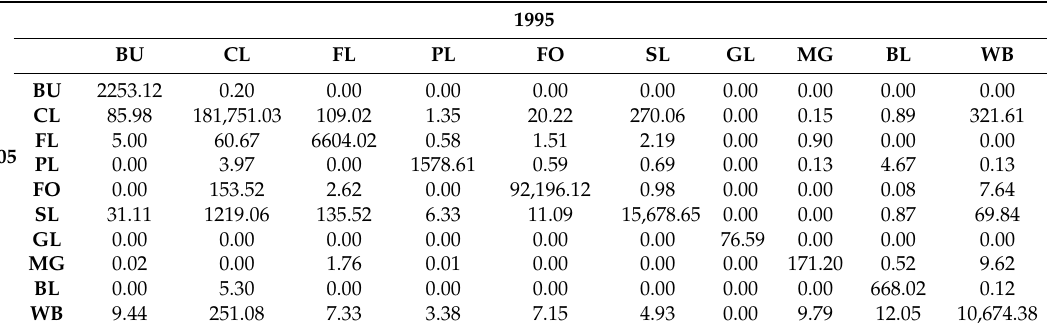
Table 4. Change detection matrix of 1995–2005.